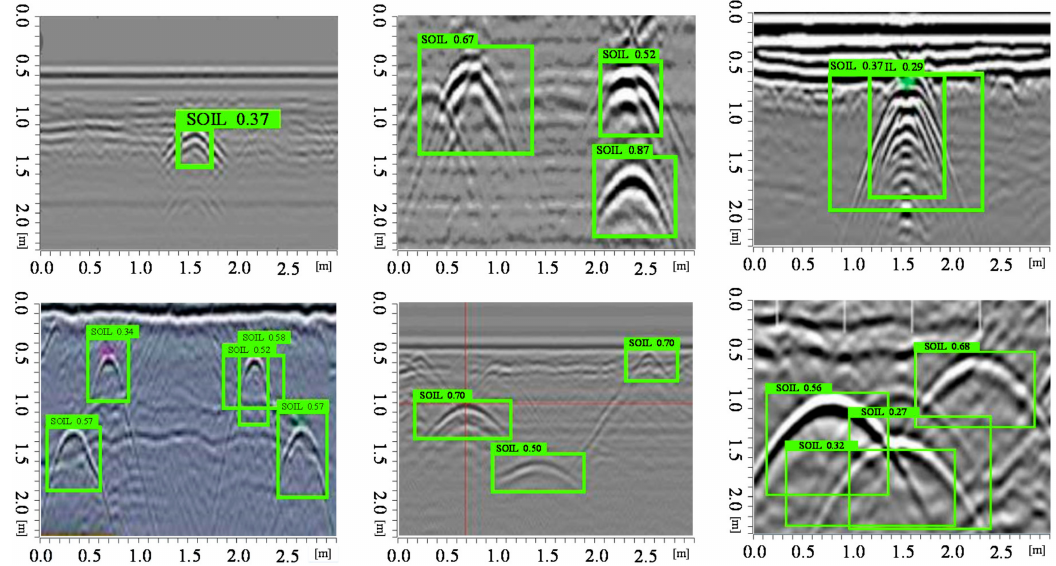
Figure 11. Single class targets detection